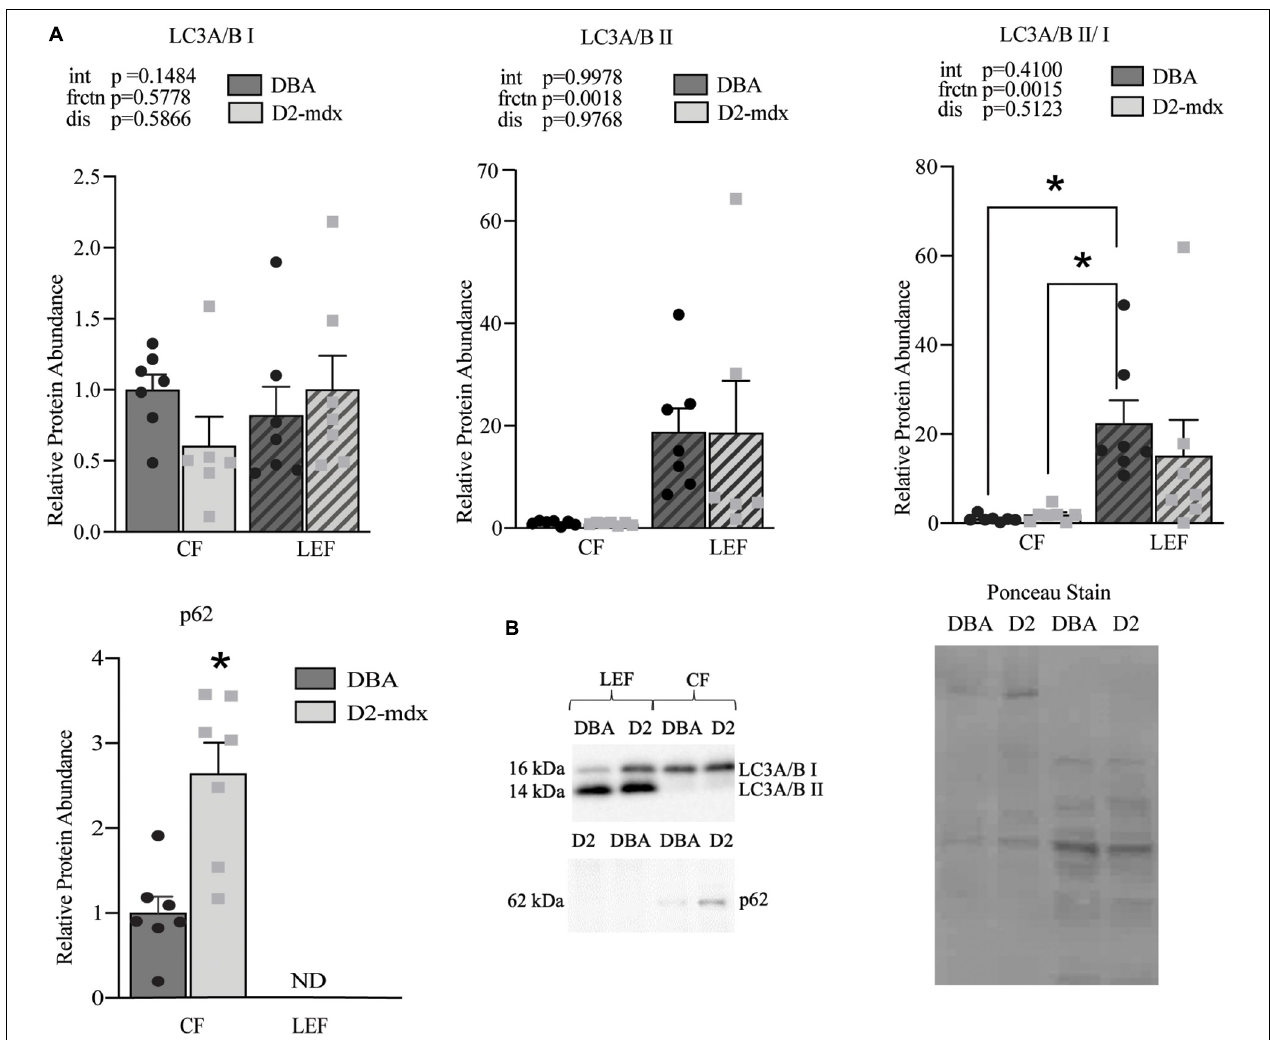
FIGURE 5 | Maintenance of autophagosome degradation in fractional assessment of dystrophin-deficient gastrocnemius muscles. Western blot quantifications of LC3A/B I and II and p62 in cytosolic and lysosome-enriched fractions from D2-mdx and DBA gastrocnemius muscles. (A) Significant main effect due to fraction in LC3A/B II and LC3A/B II/LC3A/B I. p62 was not detected in the lysosome enriched fraction and an elevated abundance was observed in D2-mdx in the CF compared to CF in DBA mice. (B) Representative western blot images and corresponding ponceau stain image. Quantifications were made relative to the cytosolic fraction from the DBA group. Significance established at p < 0.05 ( n = 7 mice per group). * Indicates significance between groups. p -values of main effects (frctn for fraction, dis for disease) and the interaction (int) are indicated, and *indicates significance between groups based on post hoc test linked by lines or by T -test